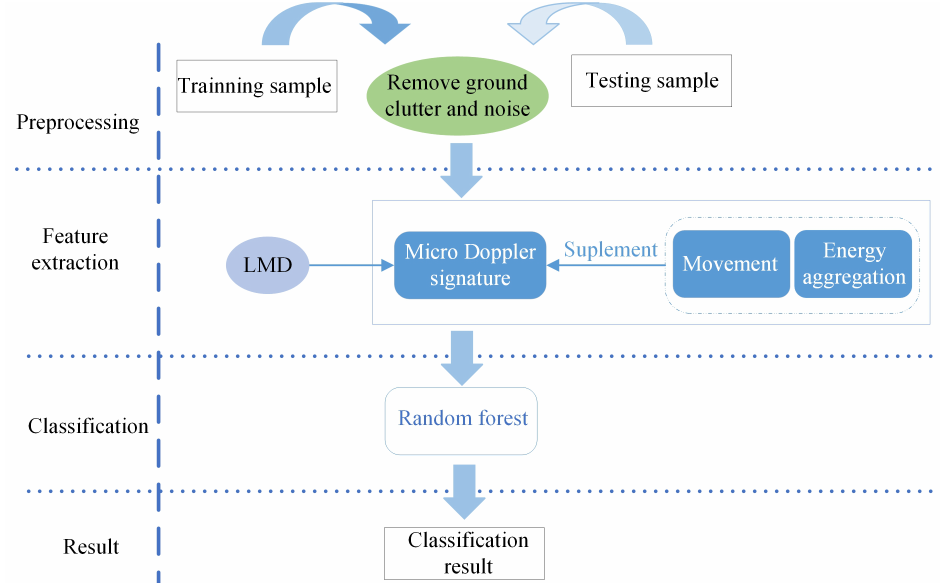
Figure 2. Proposed UAVs and birds classification system for L band staring radar. SVD is used to complete the signal preprocessing part. Subsequently, LMD is offered to perform m-DS analysis and feature extraction to achieve a better m-DS separation rate and higher decomposition efficiency. In addition, movement and energy aggregation features are extracted as a